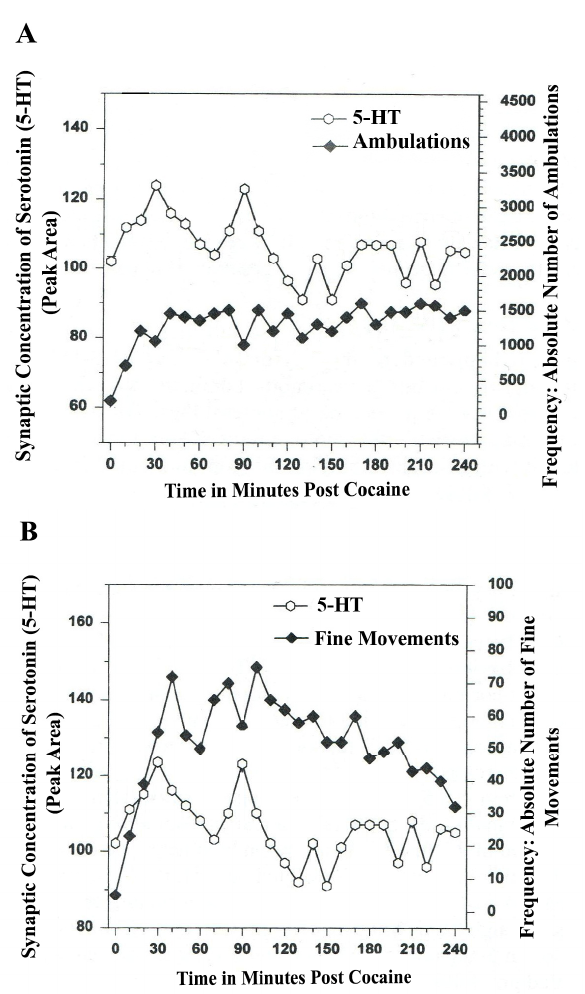
Figure 7. ( A ) Ambulations. Cocaine neurochemistry and behavior: line graph depicting endogenous 5-HT release (open circles) at basal stem nucleus, DA A , somotodendrites, 10 VTA, in real time while the freely moving, male, Sprague-Dawley laboratory rat is actually behaving, during cocaine-induced behavior (cocaine: 4 h). Baseline is not shown. ( B ) Fine Movements. Cocaine neurochemistry and behavior: Line graph depicting endogenous 5-HT release (open circles) at basal stem nucleus, DA A , somotodendrites, VTA, in real 10 time, while the freely moving, male, Sprague-Dawley laboratory rat is actually behaving, during cocaine-induced behavior (cocaine: 4-h). Baseline is not shown. Note: the figure is adapted with permission from [21]. Copyright Elsevier Limited,